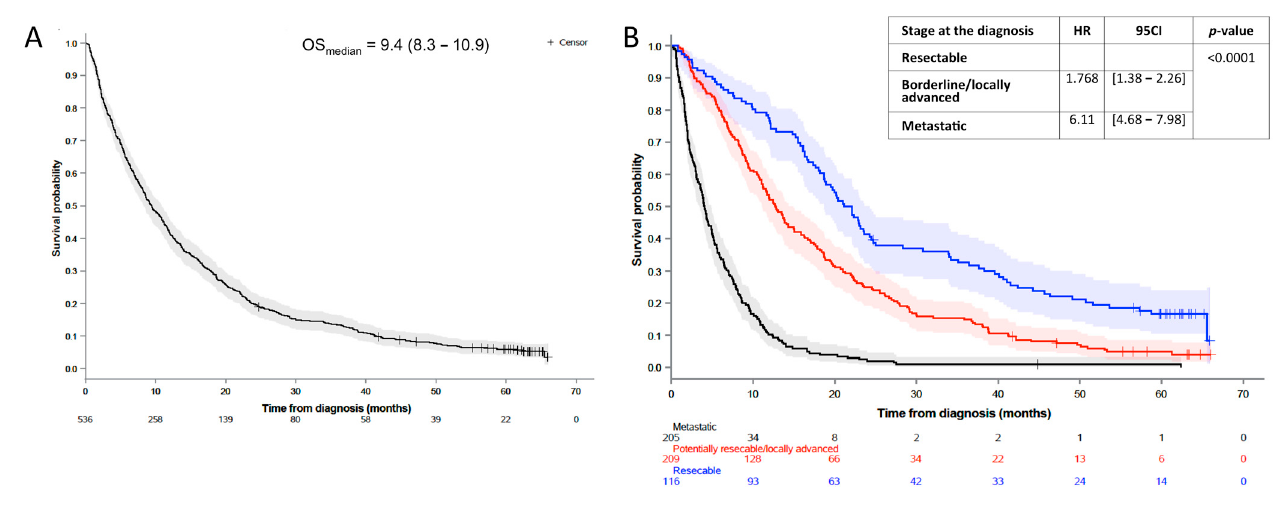
Figure 3. Overall survival of ( A ) the global cohort and ( B ) according to different stages at the diagnosis, as follows: resectable, borderline or locally advanced disease, and metastatic disease. Overall survival is presented as a median with a 95% confidence interval. The results were figured using the Kaplan–Meier method. Numbers at risk are reported under the x-axis. HR presented in the figure ( B ) are obtained after the comparison of OS between the groups after the multivariate analysis.